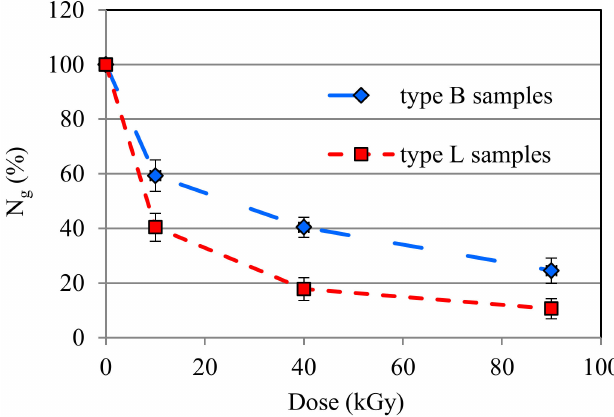
Figure 1. Results of the content of the uncrosslinked fraction (N g ) of the samples type L and